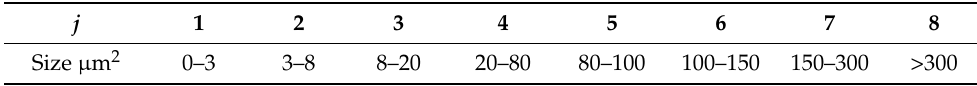
Table 2. Size-classes of